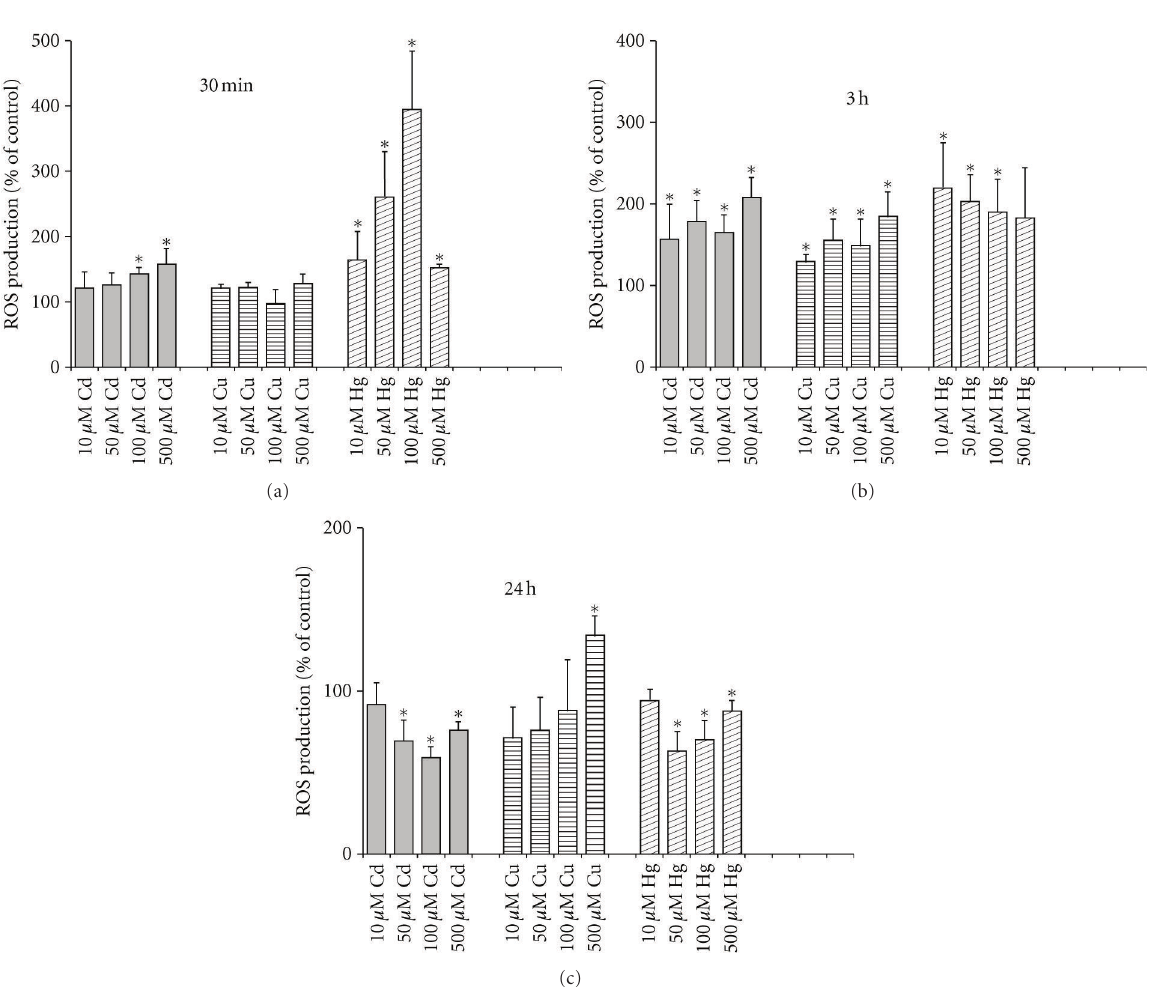
uncoupling e ff ect of that low concentration of the